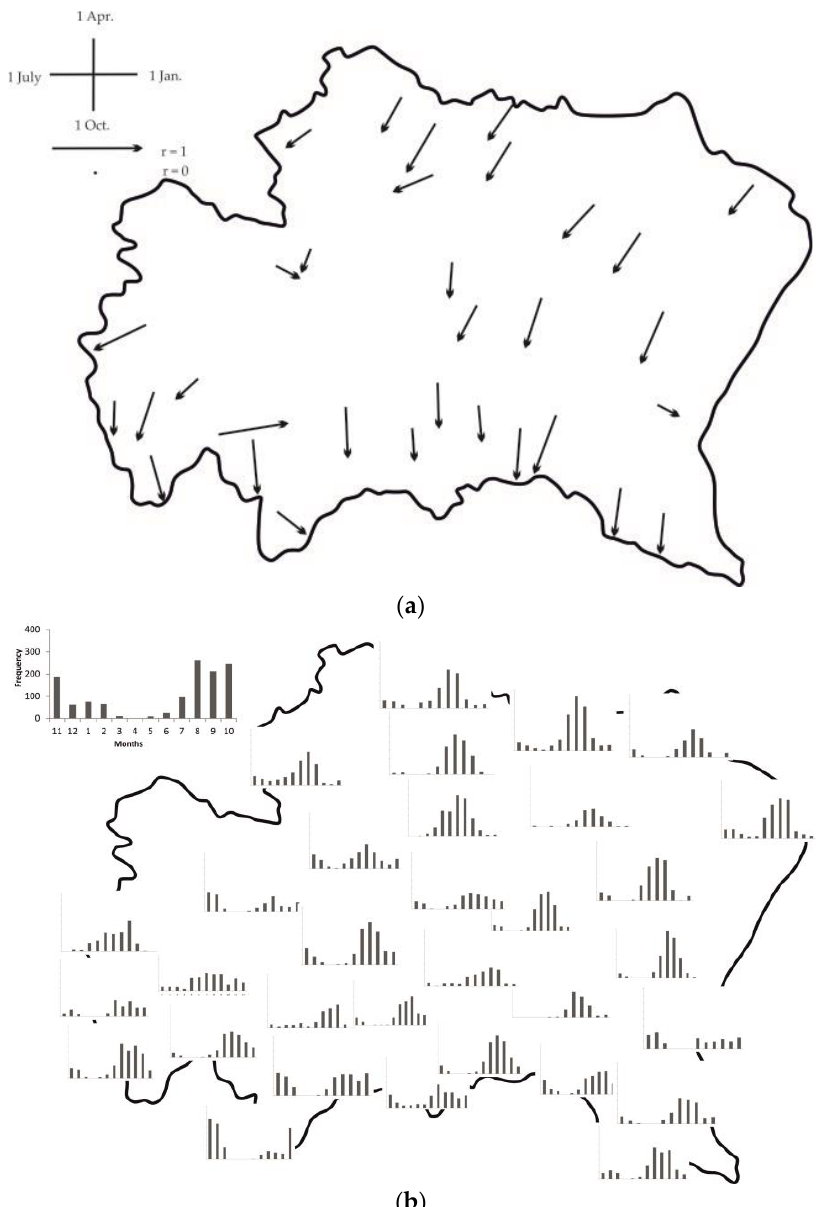
Figure 4. Map of SI ( a ) and seasonality histograms ( b ) for analyzed catchments; the x-axis is in the hydrological year for analyzed catchments and y-axis in all cases is from 0 to 400.